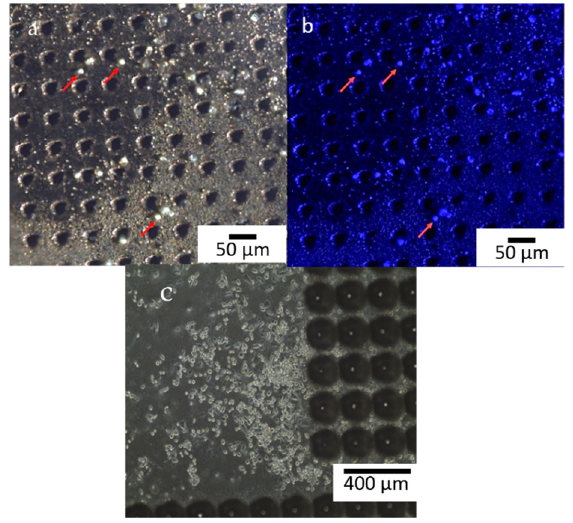
Figure 9. ( a ) Brightfield image of PC-3 cells seeded on multilayer CKC pores membrane coated with a nanometric gold layer to make it biocompatible; ( b ) Fluorescence image of PC-3 nuclei stained with DAPI between the pores of the Gold-CKC membrane. Red arrows identify ( c ) PC-3 cells seeded on CA membrane.